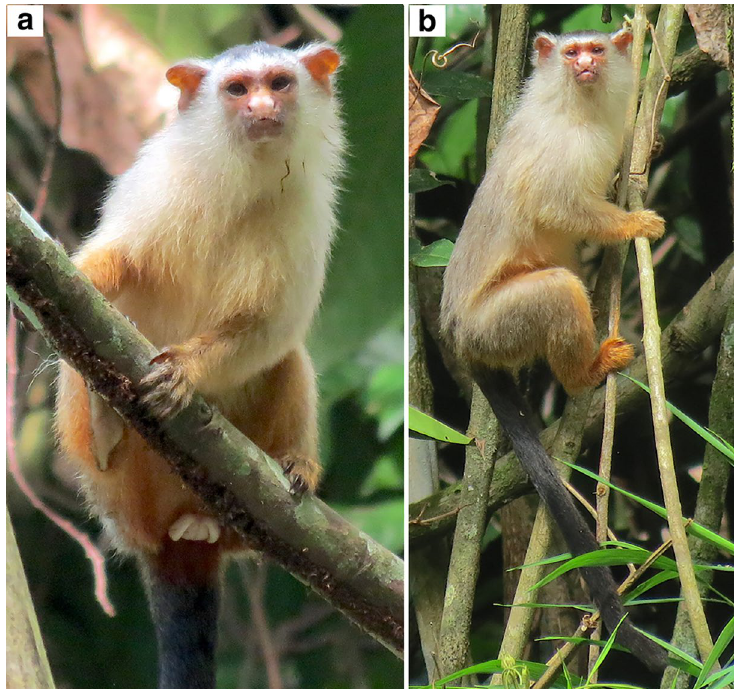
Figure 2. Schneider’s marmosets Mico schneideri sp. n. recorded at the type locality: Paranaíta, left margin of the Teles Pires River, Mato Grosso State, Brazil. (a) Adult female; (b) adult male. Photos: Diego